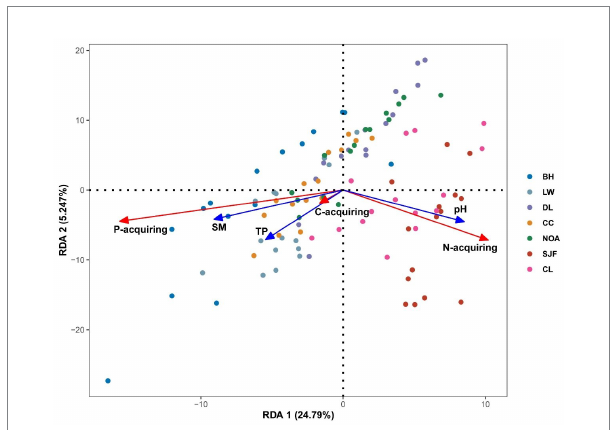
FIGURE 3 Redundancy analysis of 105 soil samples based on soil enzyme activity and dominant environmental factor ordination biplot. The overall model is significant ( p < 0.001). Environmental factors: SM, soil moisture; pH, soil acidity and alkalinity; TP, total phosphorus. Site: BH, Baihe; LW, Longwan; DL, Dongliao; CC, Changchun; NOA, Nongan; SJF, Sijianfang; CL, Changling.